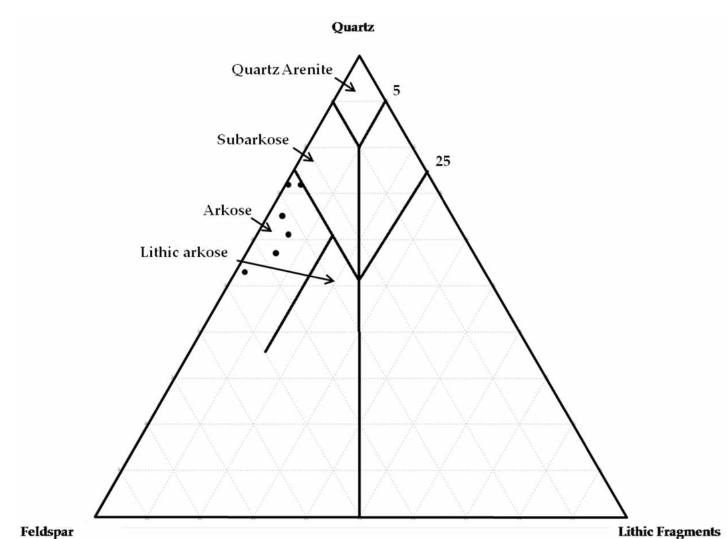
Figure 4. QFL triangular diagram (Q—Quartz, F—Feldpar and L—Lithic Fragments) displaying the classification of the sandstone reservoir of the McKee Formation in the studied wells; Modified after [24], reprinted by permission from Springer.